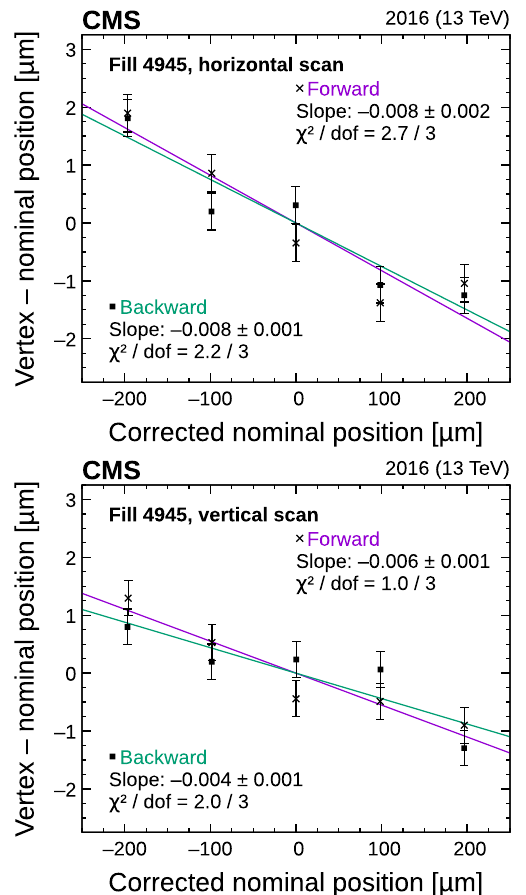
Fig. 10 Fits to LSC forward (purple) and backward (green) scan data for the x (upper) and y (lower) LSC scans in fill 4945. The error bars denote the statistical uncertainty in the fitted luminous region